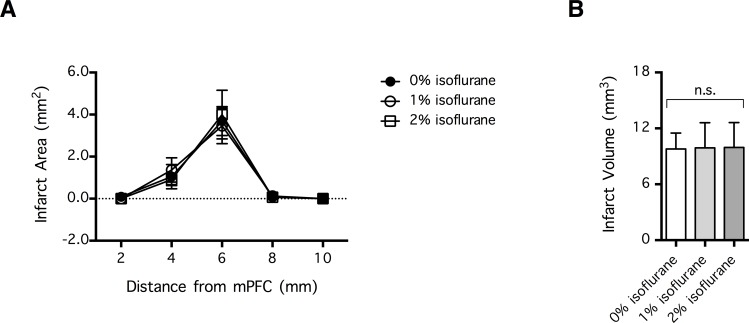
Hypothermia induced by isoflurane-anesthesia had no effect on early infarct volume following distal middle cerebral arterial occlusion (dMCAo).To induce brain infarction, mice were subjected to 120 min of dMCAo coupled with ipsilateral common carotid arterial occlusion. At 4 h post-reperfusion (6 h after the onset of ischemia), hypothermia was induced by exposure to 1% or 2% isoflurane for 1 h. Control animals received 0% isoflurane in the same gas chamber and were normothermic. (A) Infarct area per coronal section was revealed by 2,3,5-triphenyltetrazolium chloride staining 24 h post-ischemia (n = 10 per group). Data are expressed as mean ± SEM. The x-axis indicates the location of the coronal section relative to the medial prefrontal cortex (mPFC). No significant difference was detected. (B) Infarct volume derived from (A); n = 10 per group. Data are expressed as mean ± SEM. n.s. indicates no significant difference.